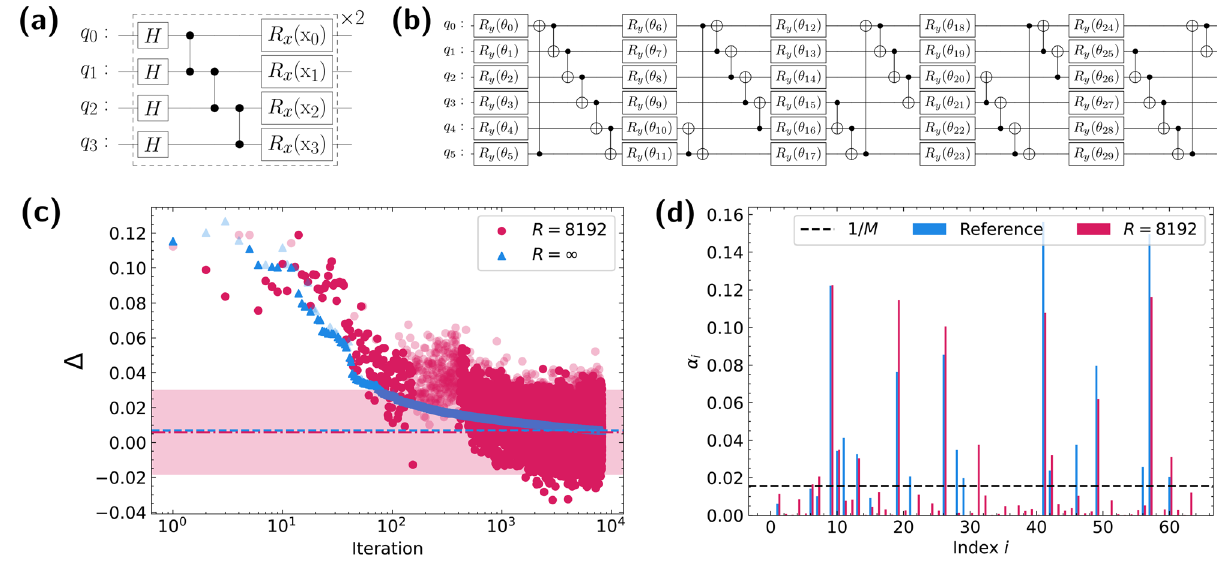
C 10 4 ). ( a ) Custom quantum feature map for the iris Figure 4. Numerical analysis on the iris dataset ( (cid:31) = = log ( M ) 30 gate parameters. ( (c ) The shaded circles and triangles dataset. ( b ) PQC design for V ( θ ) with 5 × = 2 13 ) the residual depict the training convergence outcomes of the residual losses. At the final iteration, ( t = 8192 repeated measurements (red dot-dashed line) is almost equal to the case of R loss (cid:31) for R (blue = = ∞ dashed line), where the error when estimating the expectation value is 0. The red shaded area represents the 95% 8192 case. ( d ) The spectrum of optimized weights, credible intervals of the last 16 residual losses for the R = α i s, of x i for the theoretical and R 8192 cases are compared. The dashed black line indicates the level of the = uniform weight α